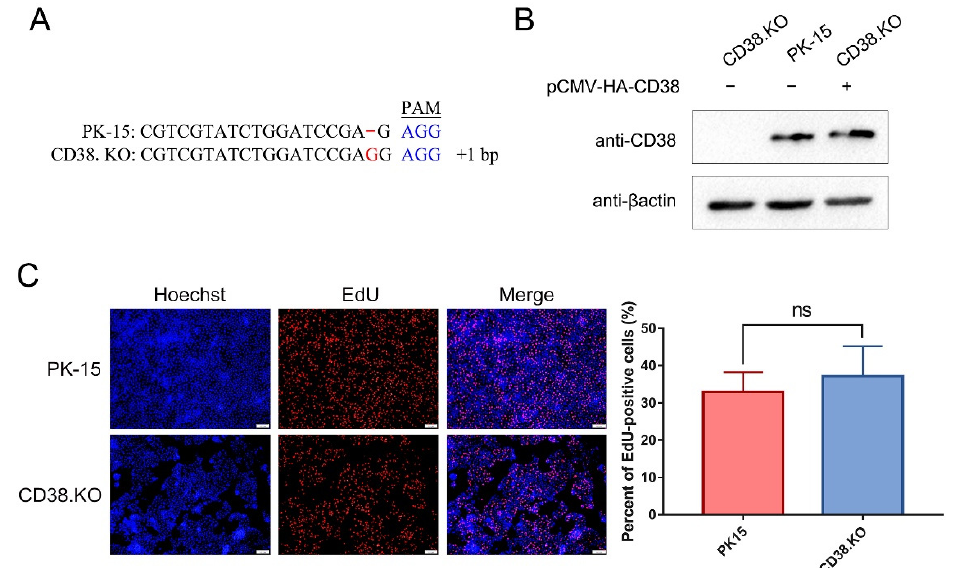
Figure 1. CD38.KO cell line was constructed and proliferated normally. ( A ) Sequence alignment between CD38.KO cells and PK-15 cells. The red font represents the sequence could not be paired, and the blue font represents the PAM sequence. ( B ) Western blotting was used to verify the expression of CD38 in CD38.KO cells, PK-15 cells, and CD38.KO cells transfected with pCMV-HA-CD38 plasmid. ( C ) PK-15 cells and CD38.KO cells were cultured for 2 h after loading EdU. After the click reaction, photos were taken with fluorescence microscope (400×), EdU-positive cells are shown in red and nuclei are shown in blue. At least 3 photos of each sample were taken, the percentages of EdU-positive cells were calculated, respectively, and the average value was taken as the final data. ns: not significant.